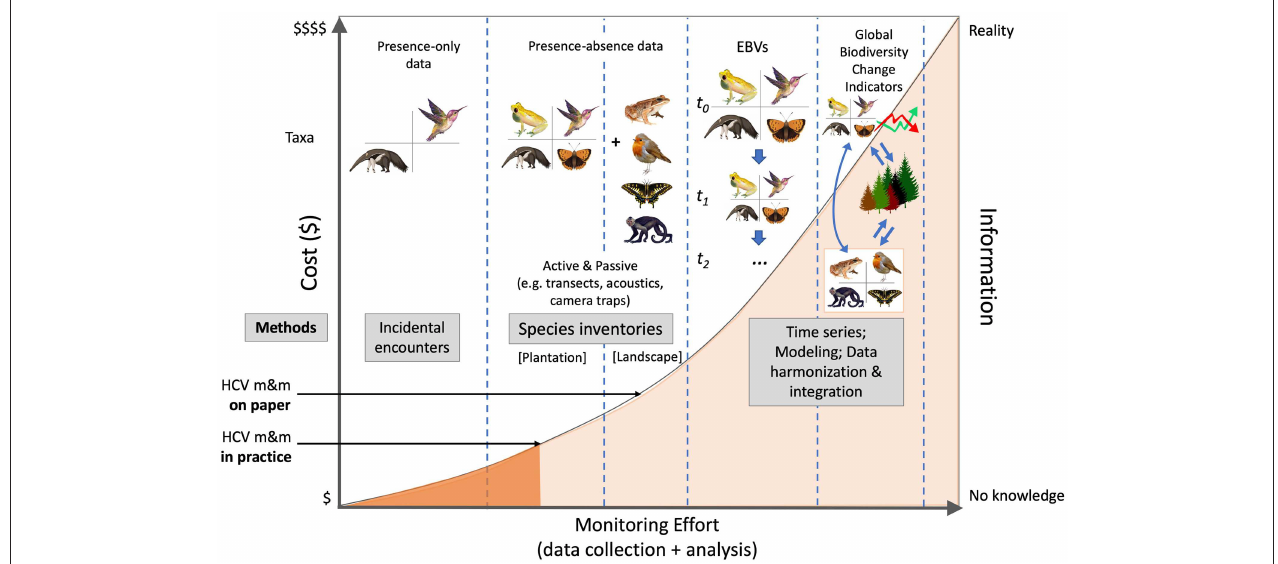
FIGURE 1 | Projected tradeoffs between improved biodiversity monitoring in oil palm landscapes and higher costs, mainly associated with analysis and interpretation of data. Area under the curve estimates the amount or quality of biodiversity monitoring acquired with different monitoring methods, and the taxa captured. Current monitoring efforts on certified plantations in Colombia are shaded in dark orange based on interviews with palm oil mills. Companies could standardize monitoring plans by utilizing EBVs (essential biodiversity variables), which can then be linked with global biodiversity change indicators across oil palm production